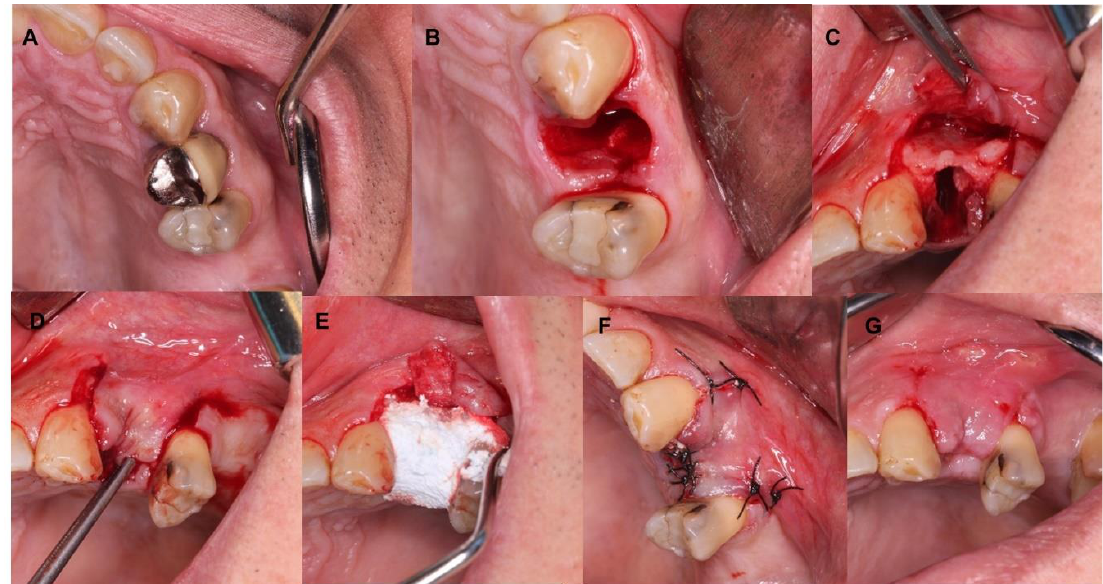
Figure 11. ( A ) Preoperative occlusal view; ( B ) Dental extraction of 24; ( C ) Mucoperiosteal flap; ( D ) Passivity check; ( E ) Placement of Bond Apatite ® ; ( F ) Closing by the first intention; ( G ) One-week follow-up.